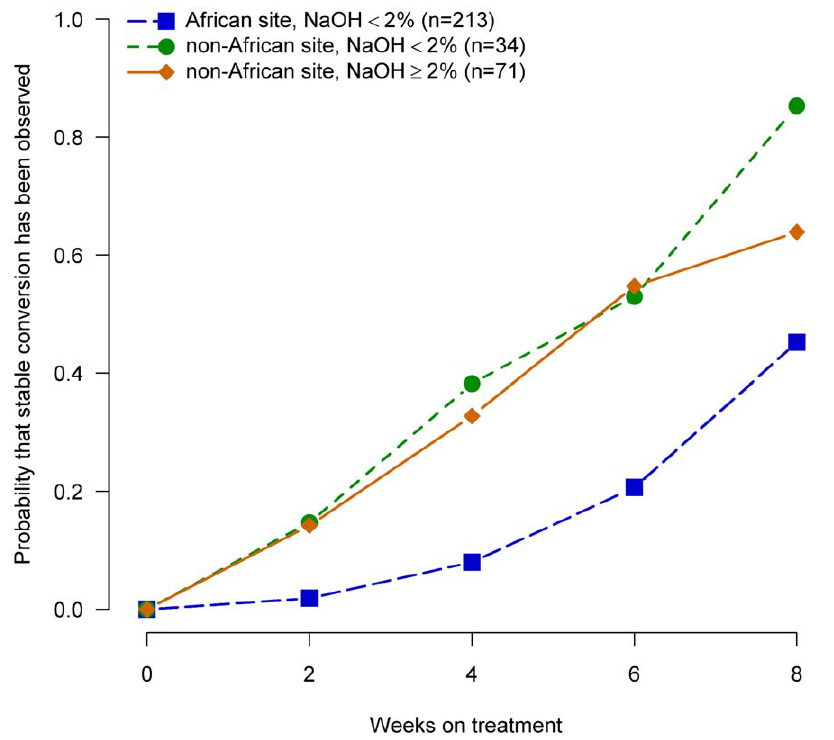
Figure 8. Probability of sputum culture conversion in liquid media by NaOH final concentration used for specimen decontamination, African/non-African site and week of treatment, TBTC Study 28 protocol-correct